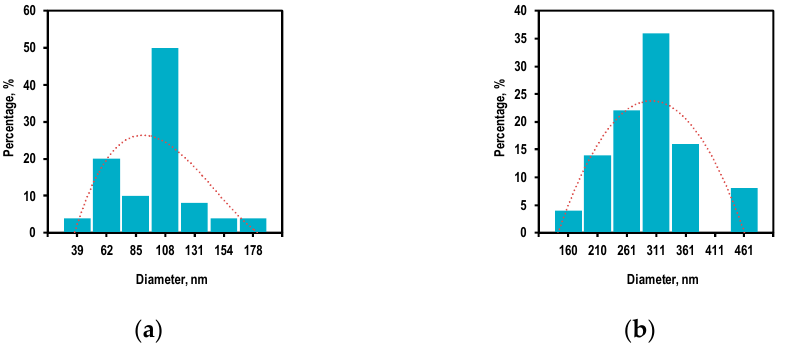
Figure 8. The transverse size distribution of the ZnO structures obtained by the PECVD method at the various temperatures in the reactor deposition zone: ( a ) 250 °C; ( b ) 350 °C.